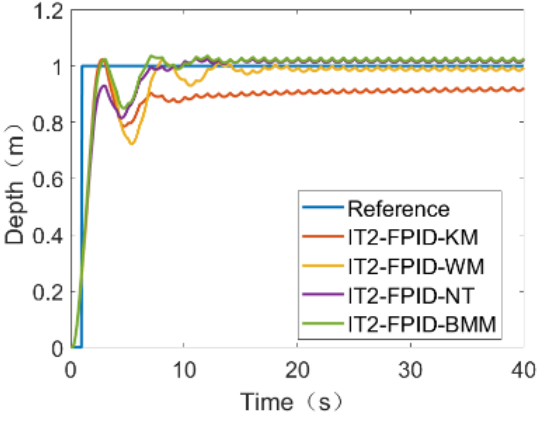
Figure 6. The simulation results of impulse noise.